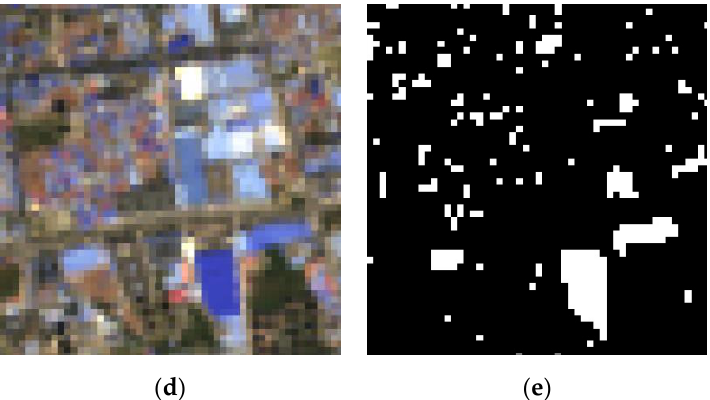
Figure 1. ( a ) True-color (red–green–blue) composite of Sentinel-2 image; ( b ) pixels that were both identified as vegetation and soil in ( a ); ( c ) true-color (red–green–blue) composite of Google Earth image; ( d ) true-color (red–green–blue) composite of Landsat-8 image; ( e ) pixels that were both identified as vegetation and soil in ( d ). Note that all the images in this figure are zoomed to be the same size for an easy comparison.